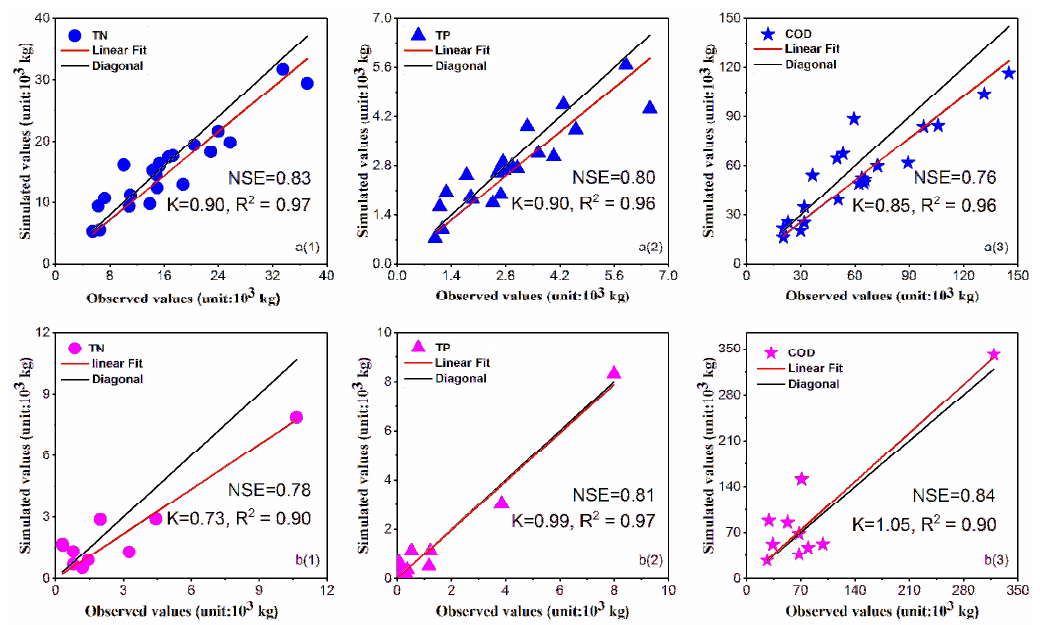
Figure 4. Simulated and actual values of pollutant emissions by agricultural households and factories: ( a1 – a3 ) represent total nitrogen (TN), total phosphorus (TP), and chemical oxygen demand (COD) discharge by agricultural household agents, respectively, and ( b1 – b3 ) represent TN, TP, and COD discharge by factory agents, respectively.